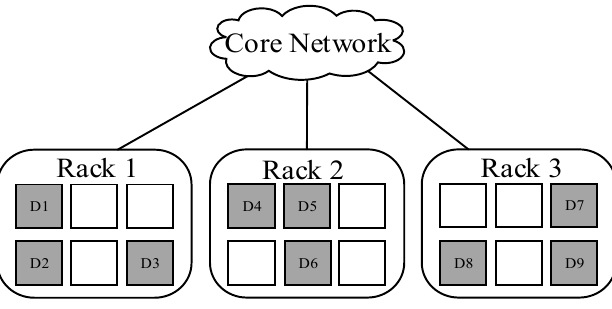
Figure 4. A kind of placement across 3 racks ( c = 3) .